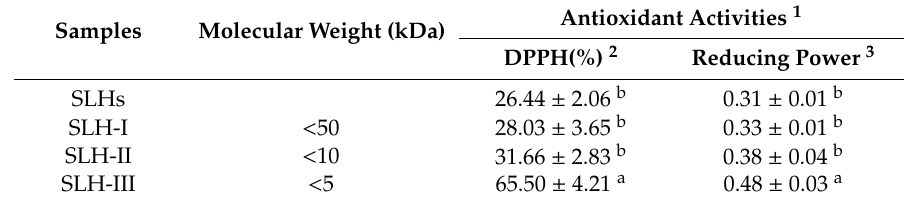
Table 2. Antioxidant activity of S. limacinum hydrolysates (SLHs) and their fractions from